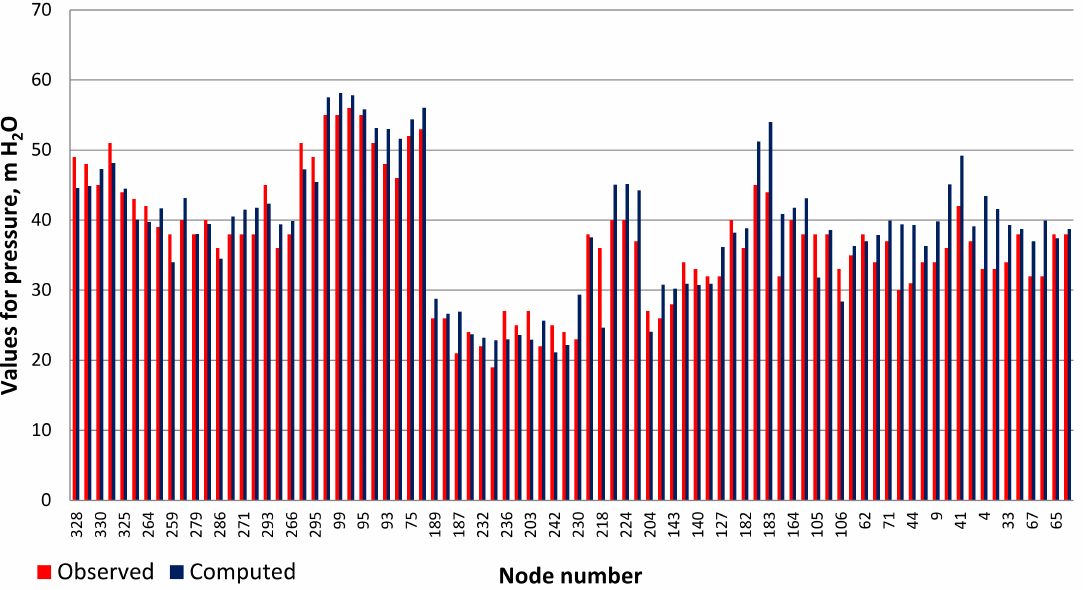
Figure 3. Comparison of the pressure parameter for the nodes: computed and